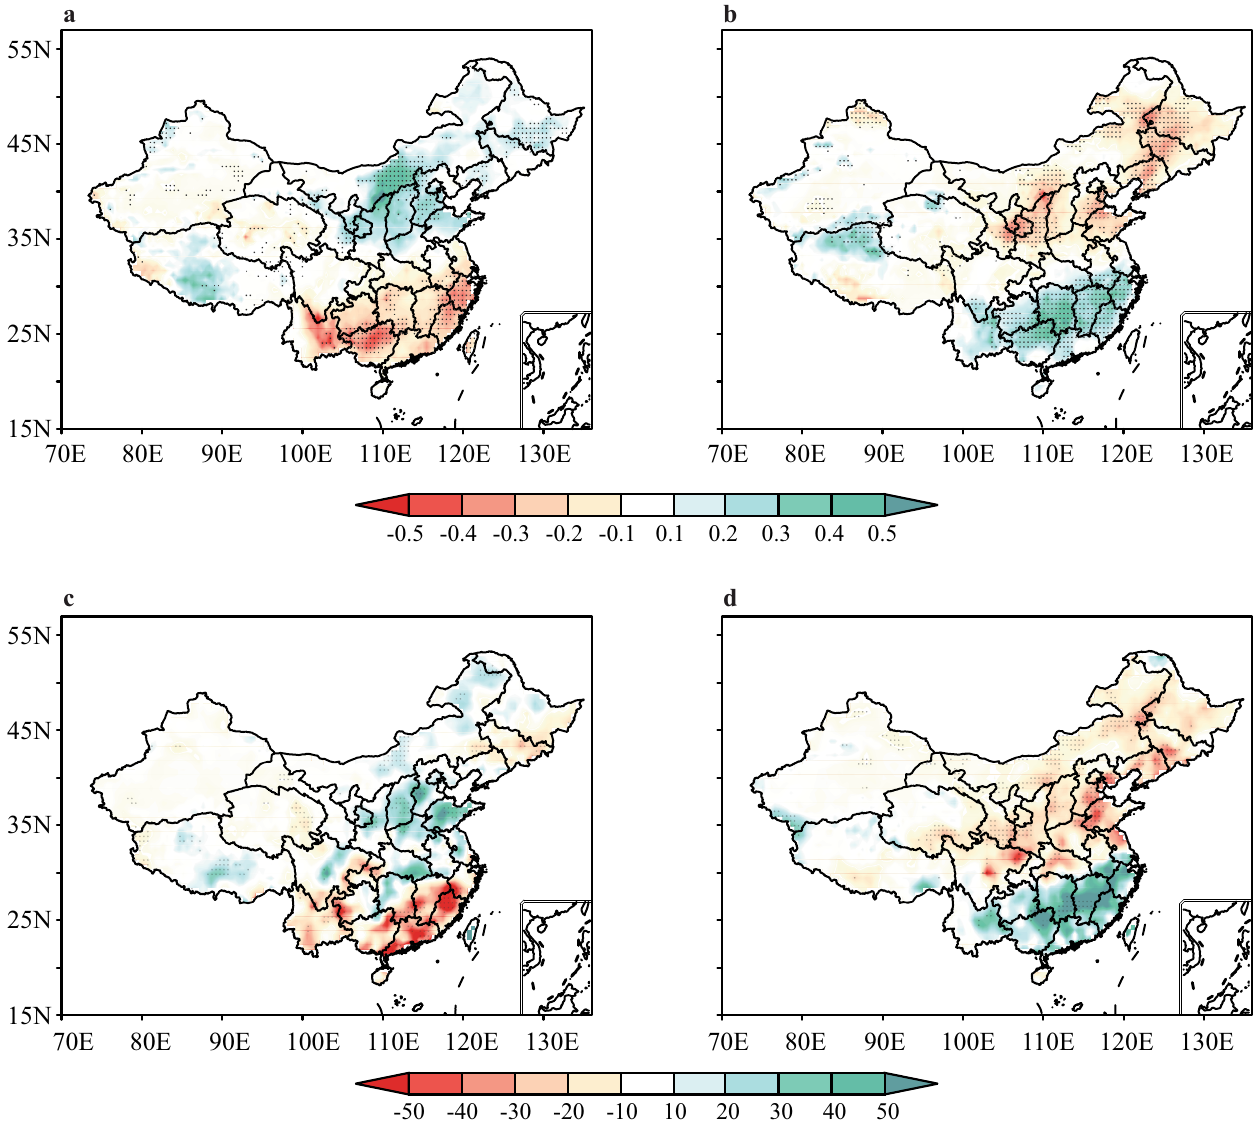
Fig. 3 The SM and precipitation composite anomalies. The a , b SM (unit: (m 3 m − 3 )*10 2 ) and c , d precipitation (unit: mm) anomalies for the a , c SMI wet and b , d SMI dry composite. The stippling indicates signi fi cant (95% con fi dence) composite differences from the mean interannual fi eld during 1981 –